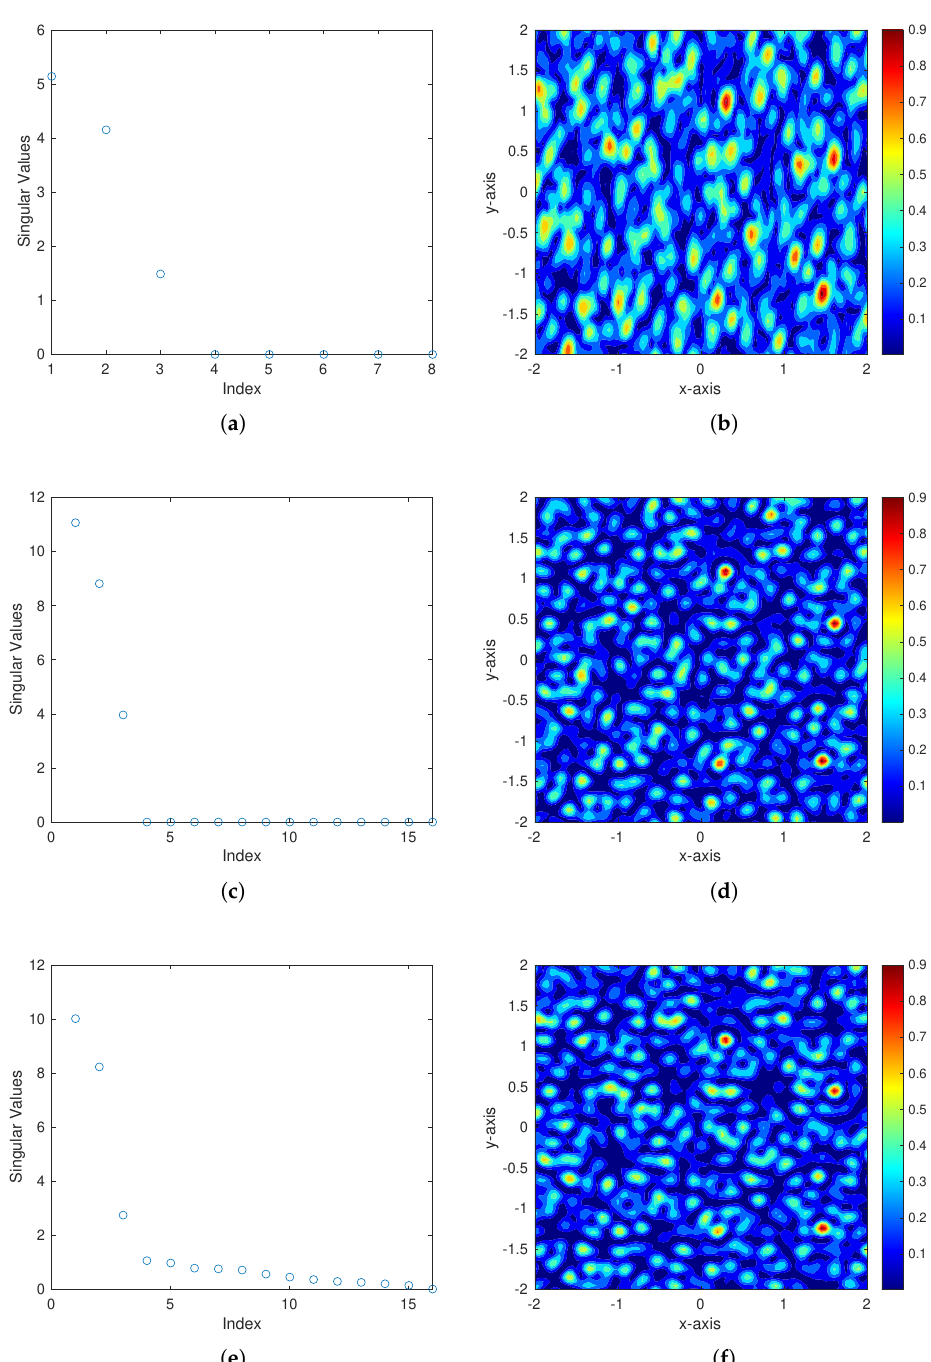
Figure 14. Imaging result and singular value distribution for limited view data (top), ground truth data (middle), output data (bottom). ( a ) SVD with limited-view data; ( b ) imaging result with limited view data; ( c ) SVD with true data; ( d ) imaging result with true data; ( e ) SVD with learning data; ( f ) imaging result with learning